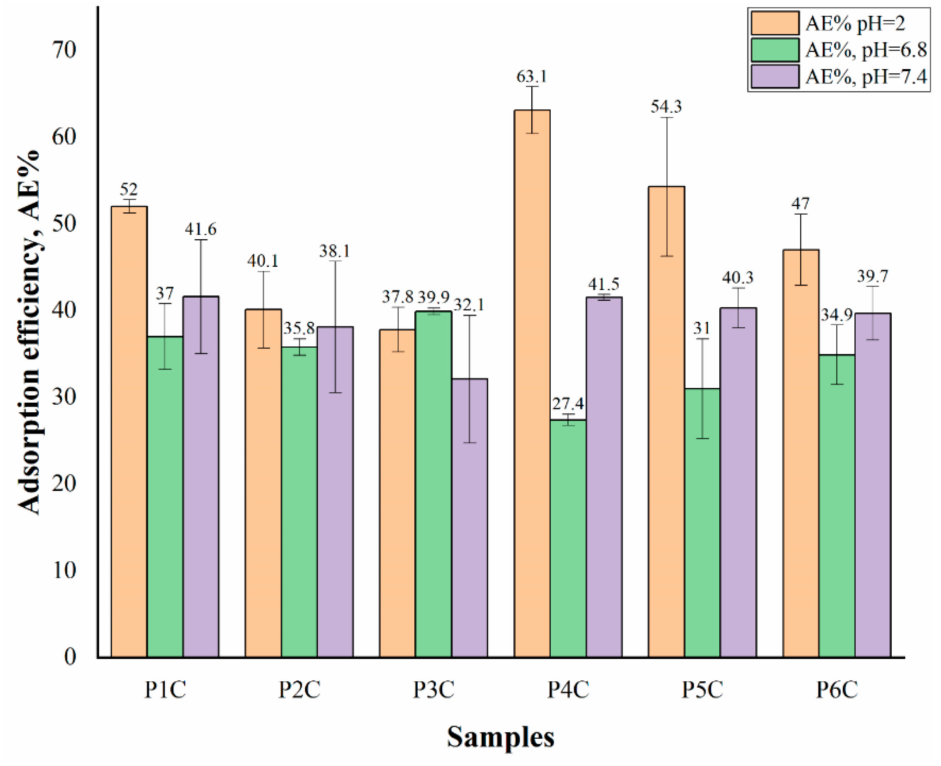
Figure 11. Bovine serum albumin (BSA) adsorption efficiency (AE%) for all samples obtained after simultaneous placement of the ComPs at pH = 2 (blue), pH = 6.8 (red), and pH = 7.4 (green). Results are expressed as mean values ±